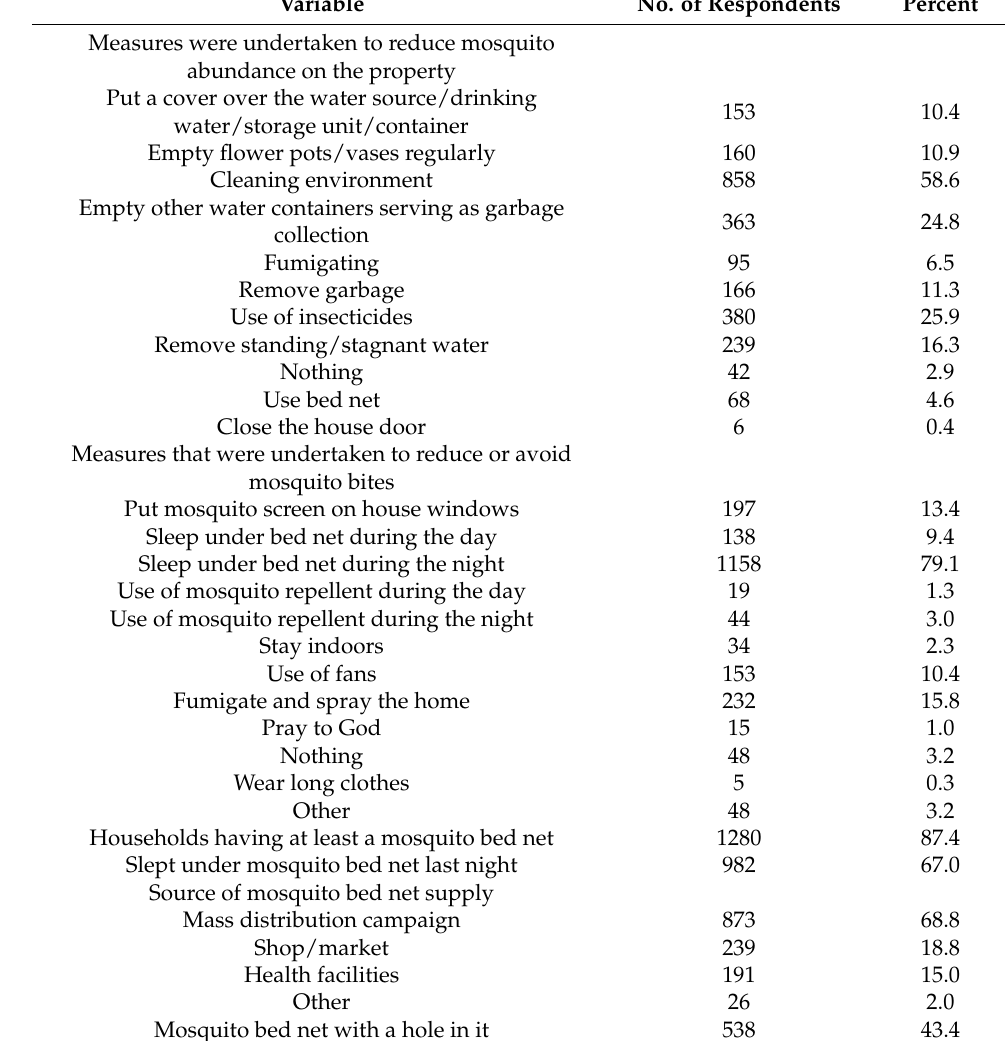
Table 10. Practices related to mosquitoes and mosquito-borne